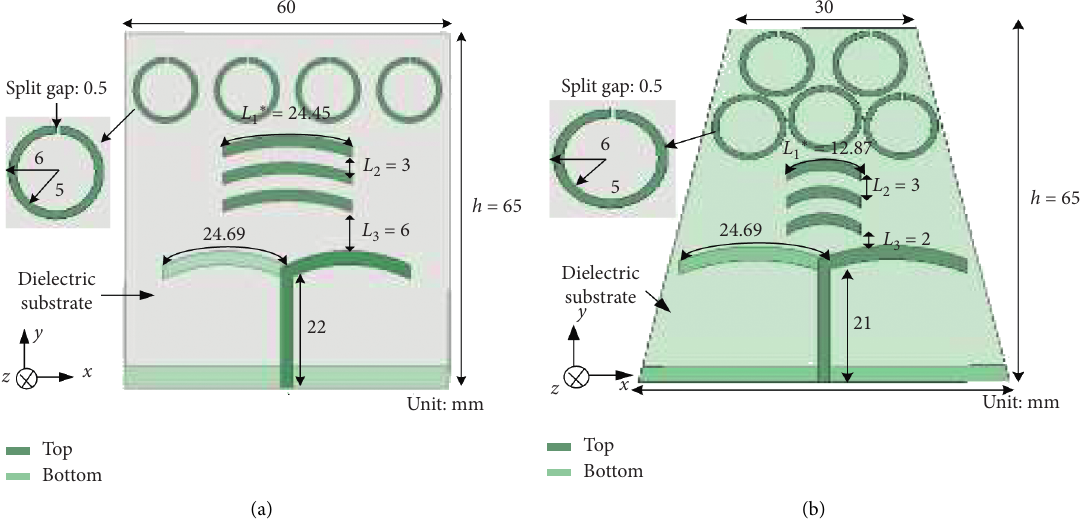
Figure 6: Layout and design parameters of the proposed compact quasi-Yagi antennas with bent arms. (a) Compact rectangle quasi-Yagi antenna. (b) Compact trapezoid quasi-Yagi